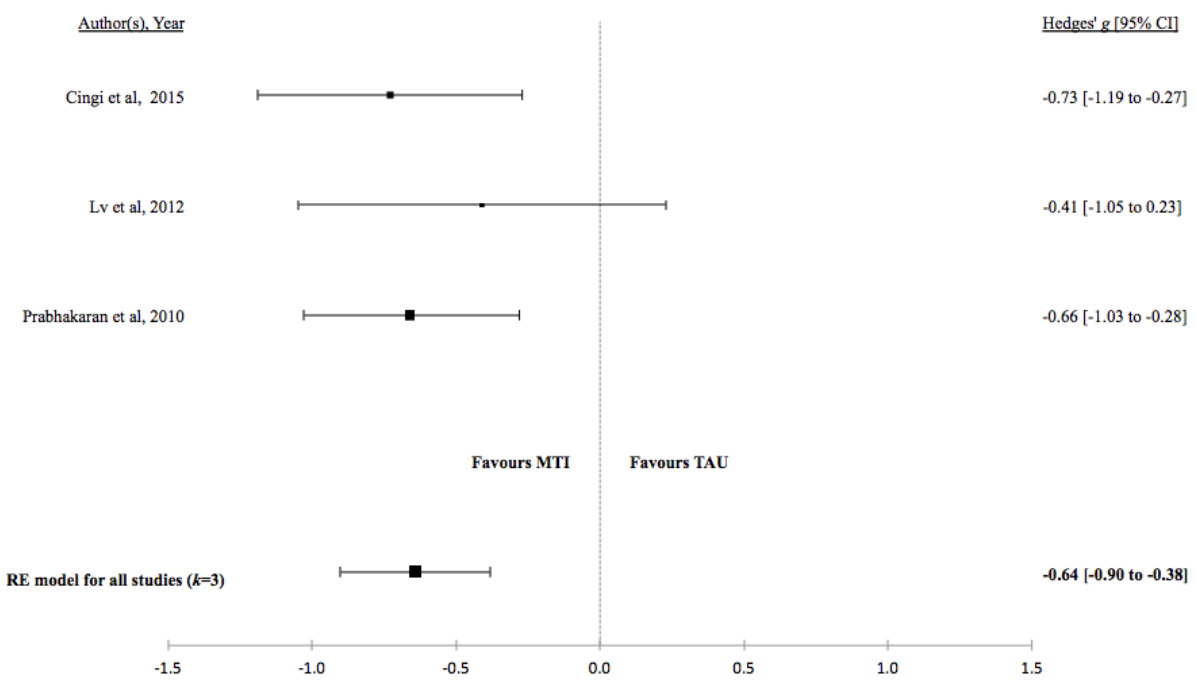
Figure 15. Forest plot of the standardized mean difference in unscheduled visits between MTI and standard treatment. MTI: mobile technology intervention.